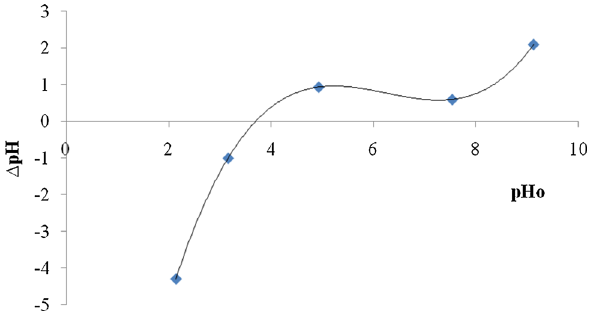
Fig. 4 Plot of pH pzc of activated coconut